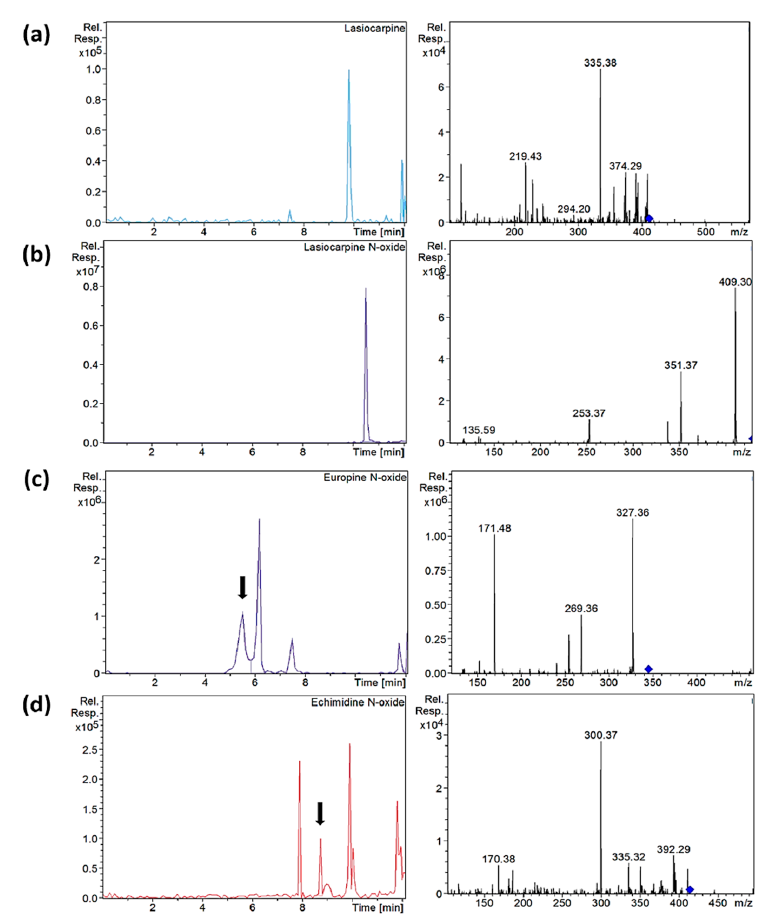
Figure 5. Extracted ion chromatograms and mass spectra (MS 2 ) of ( a ) lasiocarpine in sample C-S10, ( b ) lasiocarpine N -oxide in sample C-S10, ( c ) europine N -oxide in sample O-S9 and ( d ) echimidine N -oxide in sample C-S14 after µ-QuEChERS extraction. Chromatographic conditions as Table 1.